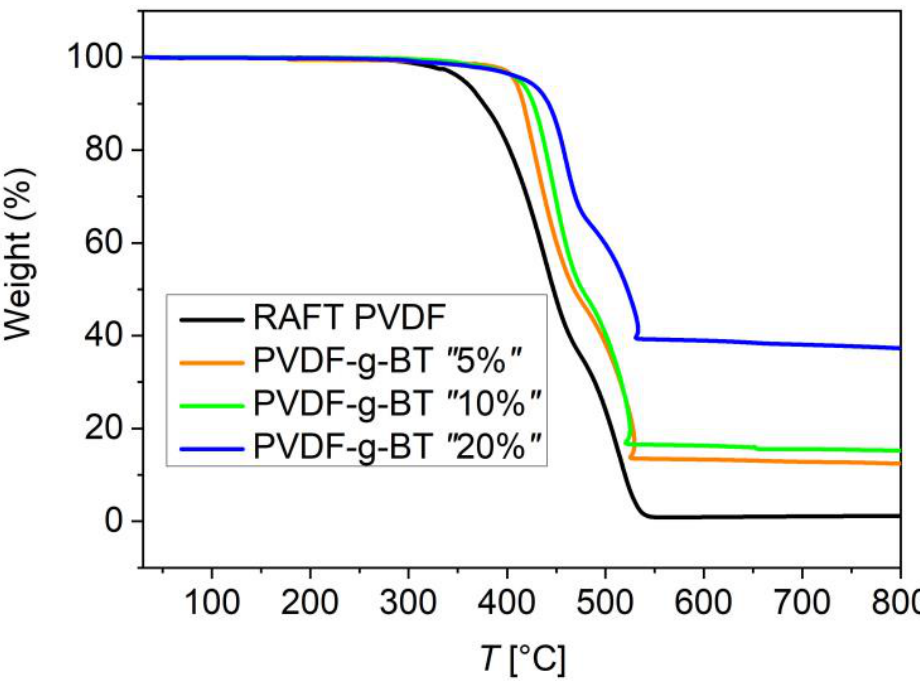
Figure 1. TGA thermograms of the neat RAFT PVDF sample as well as of the nanocomposites with the three different BT fractions. Table 1. Weight loss at 700 ◦ C, specific melting enthalpy ∆ H m , and derived crystalline fraction X , for the different PVDF- g -BT nanocomposites. Additionally the residual ungrafted polymer obtained by purification of the 10 wt% BT nanocomposite was